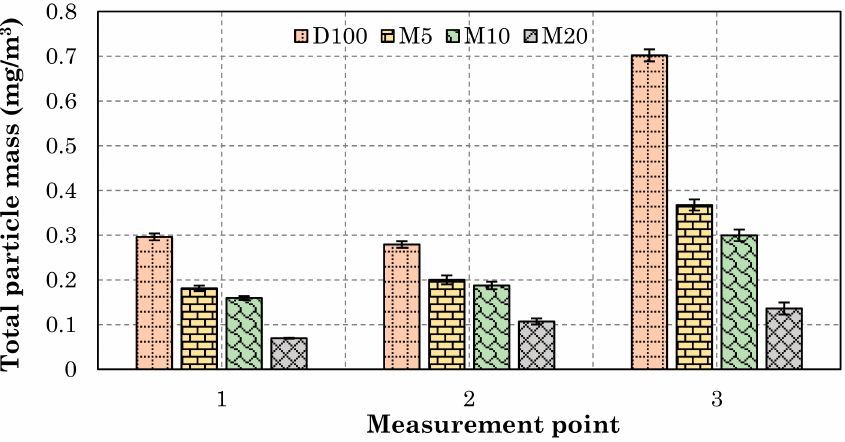
Figure 17. The total mass of soot particles in size range 5.6–560 nm for all test fuels at all measurement points (error bars represent the standard